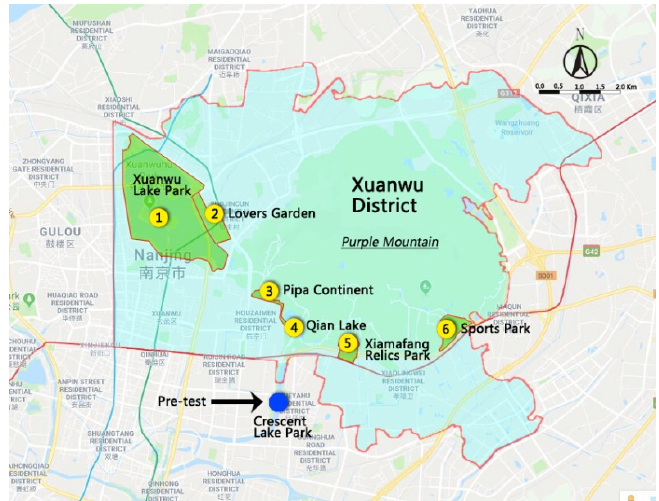
Figure 1. Urban parks in the Xuanwu District, Nanjing City (Source: Google Maps).